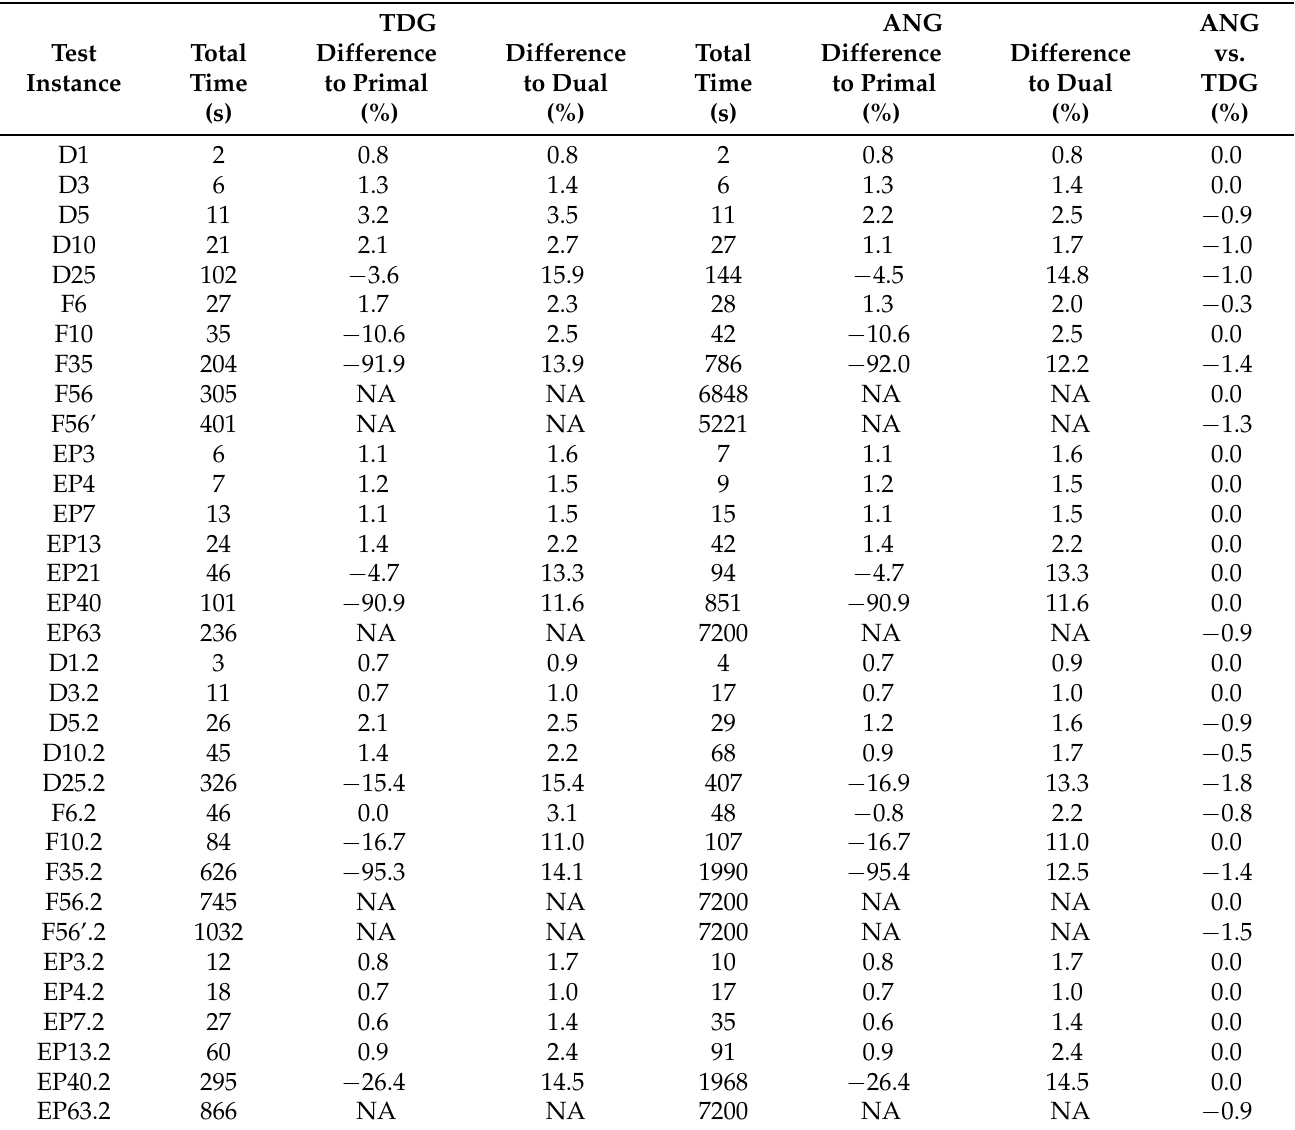
Table 4. Solution values found by the